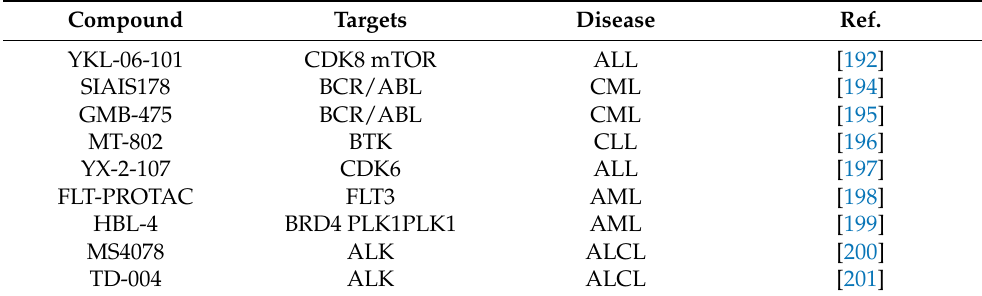
Table 3. Molecular targets and target disease of Proteolysis Targeting Chimeras (PROTAC) agents. Compound Targets